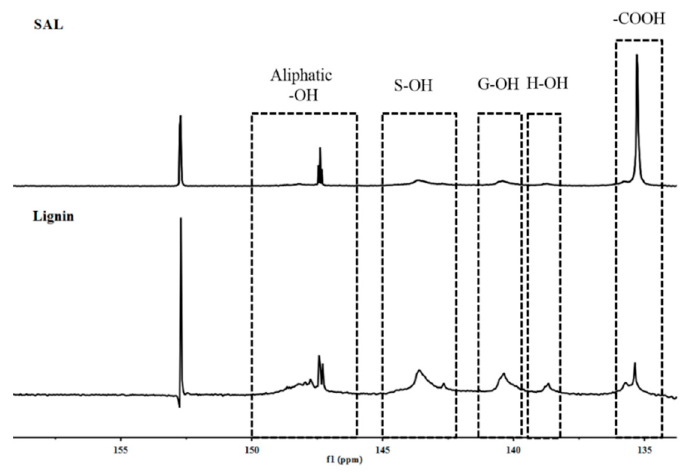
Figure 4. 31 P NMR spectra of S-lignin and SS-lignin. Table 2. Content of hydroxyl groups and carboxylic group in Acidified lignin and carboxyl lignin. Functional groups